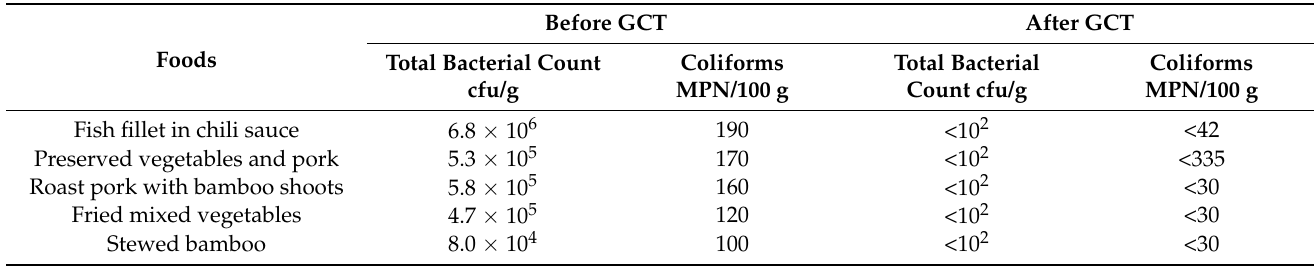
Table 1. Changes in the amount of food bacteria before and after GCT .